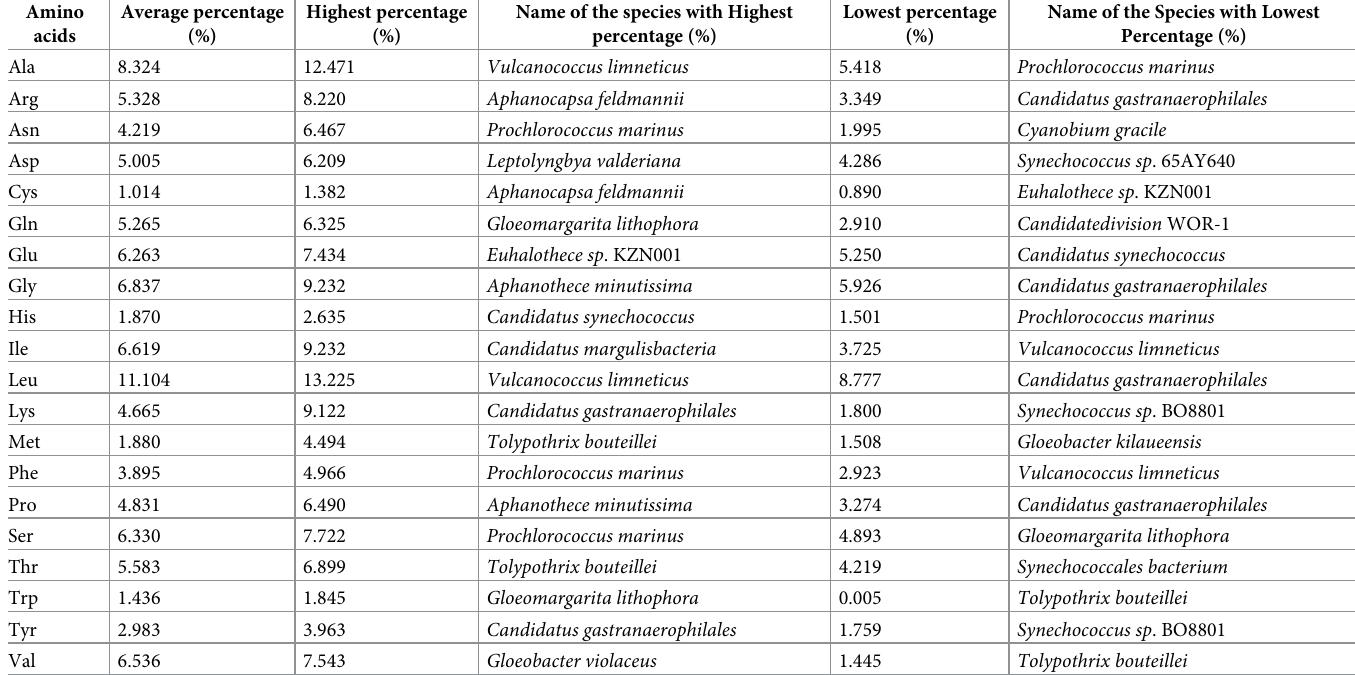
Table 1. Average amino acid composition of cyanobacterial proteomes. Cyanobacterial species with highest and lowest abundance of amino acids are depicted here. Amino Average percentage acids